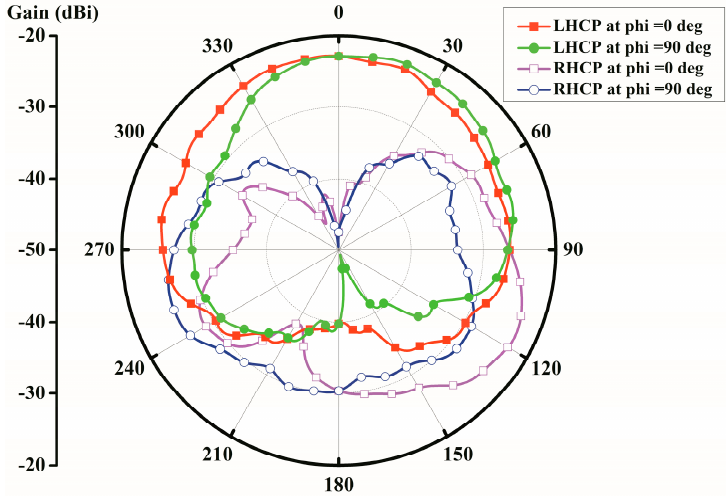
Figure 4. Simulated radiation patterns at 2.45 GHz.